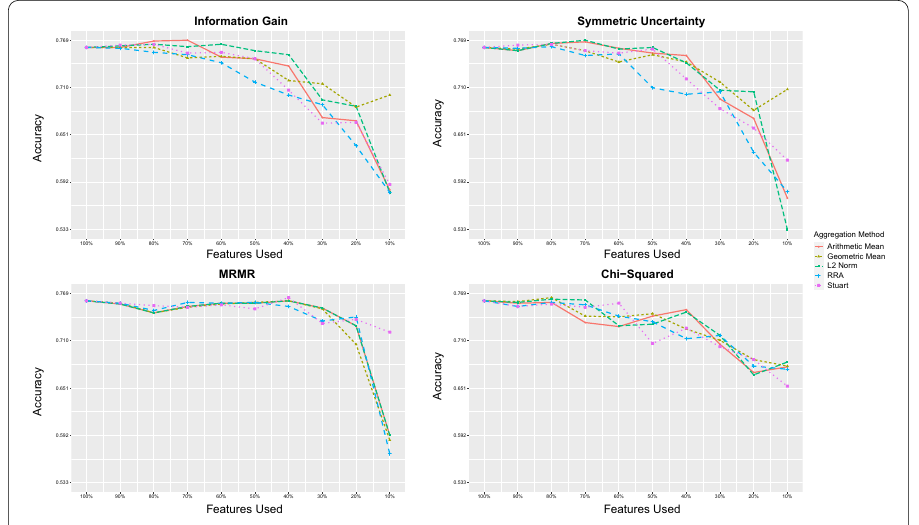
Fig. 3 Jasmine dataset classification